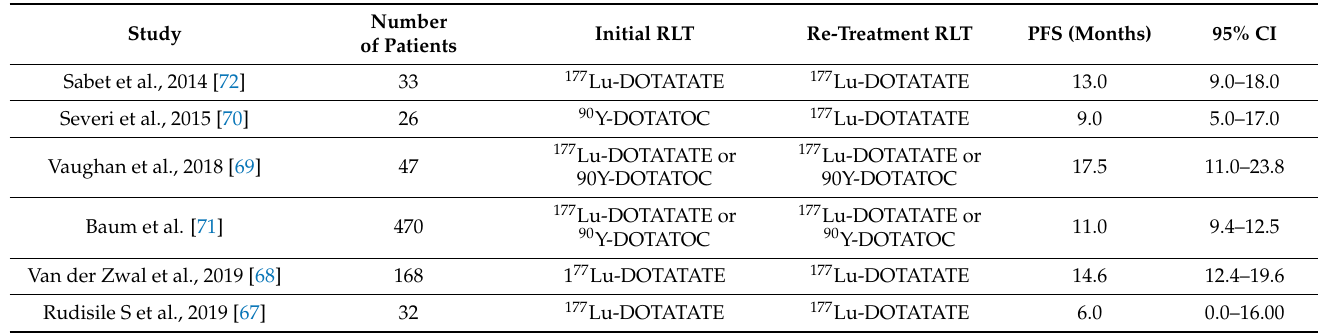
Table 2. Efficacy of radioligand therapy re-treatment in patients with advanced